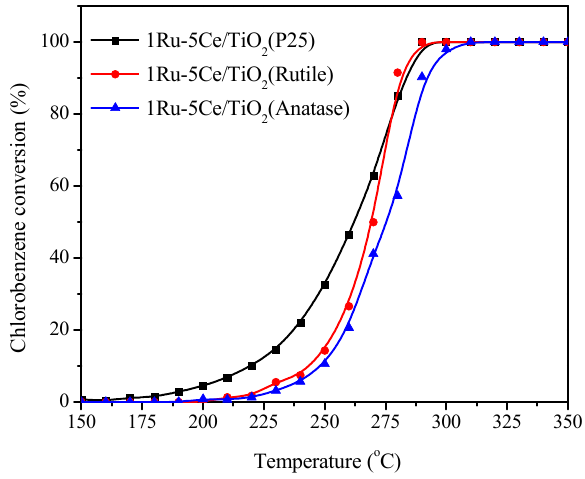
1Ru ‐ 5Ce/TiO 2 (P25), and 1Ru ‐ 5Ce/TiO 2 (Anatase) were 279, 283, and 290 °C, respectively.